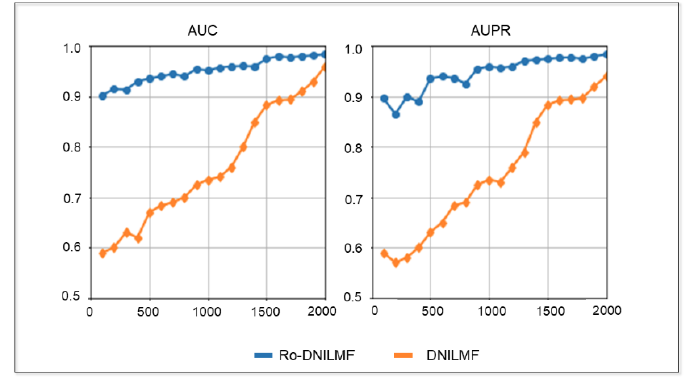
Figure 4. The AUC and AUPR with the different number of samples.